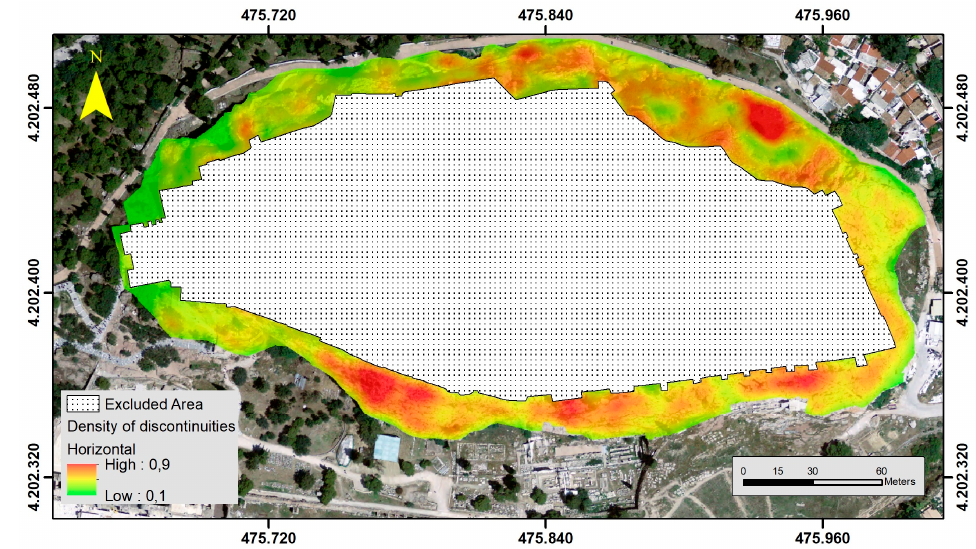
Figure 8. Instability related parameters (normalized): Density of discontinuities—horizontal.